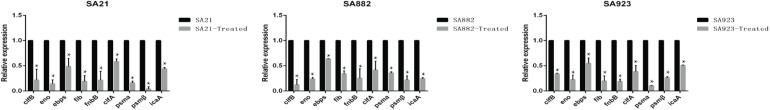
Effect of ZY-214-4 on relative expression of biofilm-related genes in S. aureus. Values represent mean ± SD. Cells grown without ZY-214-4 served as a control. *P < 0.05.